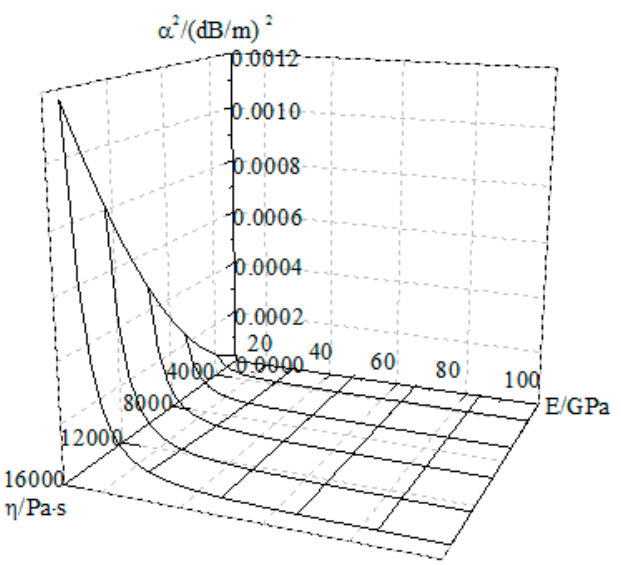
Figure 8. Variations in the attenuation factor with the elastic modulus and the viscosity coefficient.